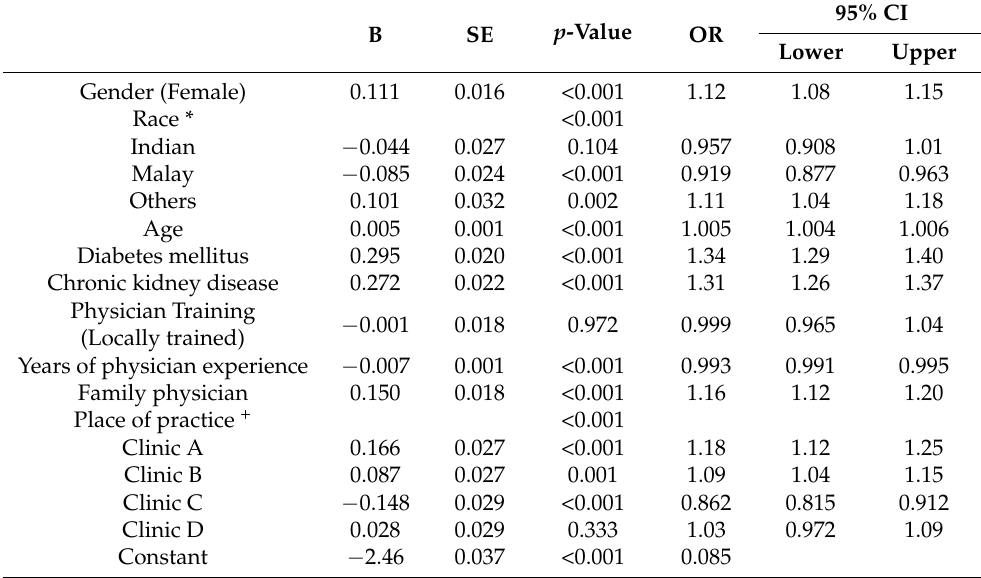
Table A2. Multivariate logistic regression for factors predisposing to antibiotic prescriptions for undefined conditions, 2018–2021.